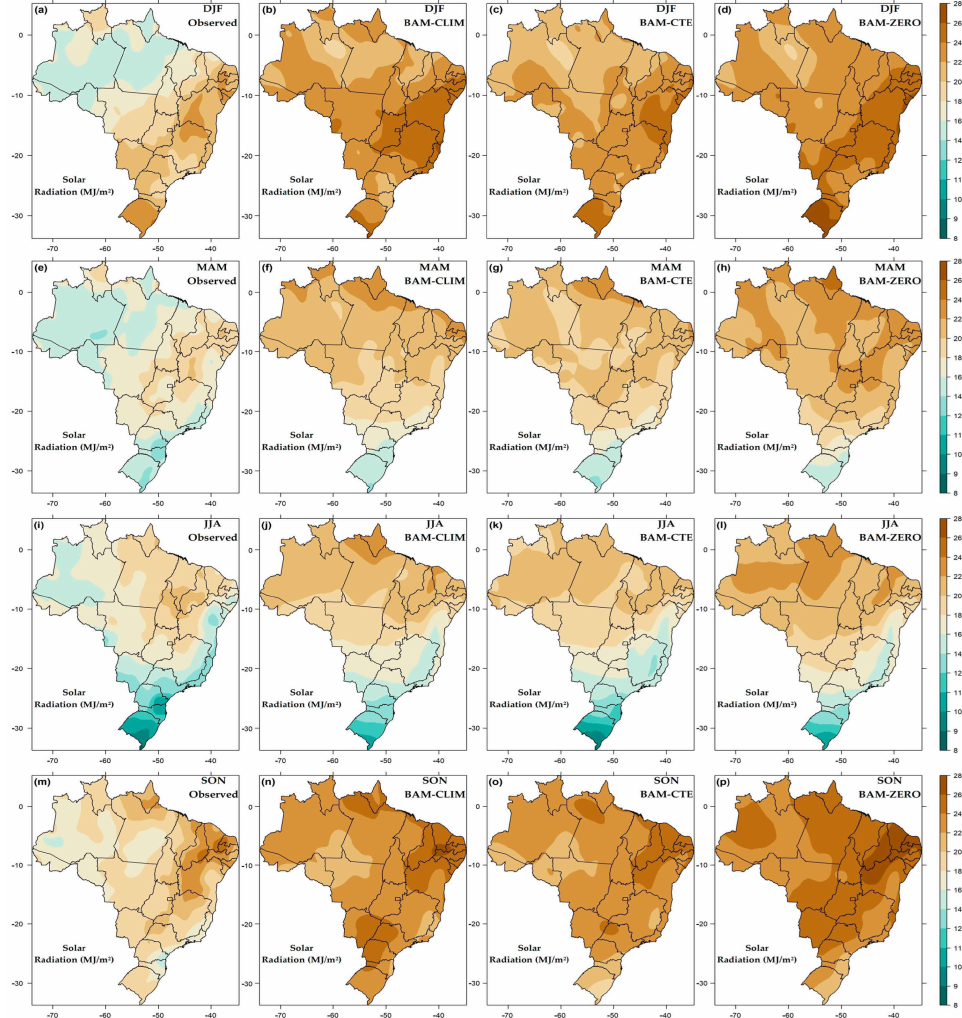
Figure 2. Seasonal averages of solar radiation (MJ/m 2 ). In the upper panel, values obtained for summer (DJF) from observations ( a ), BAM-CLIM ( b ), BAM-CTE ( c ), and BAM-ZERO ( d ). In the second panel, the same for autumn (MAM) from observations ( e ), BAM-CLIM ( f ), BAM-CTE ( g ), and BAM-ZERO ( h ). In the third panel, the same for winter (JJA) from observations ( i ), BAM-CLIM ( j ), BAM-CTE ( k ), and BAM-ZERO ( l ). In the last panel, the same for spring (SON) from observations ( m ), BAM-CLIM ( n ), BAM-CTE ( o ), and BAM-ZERO ( p